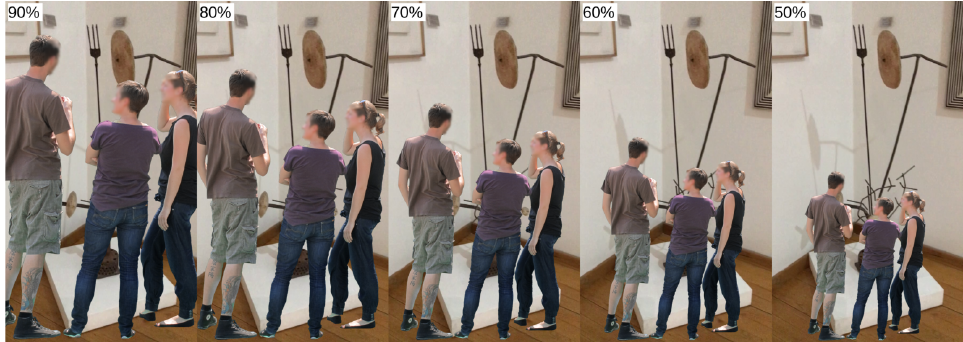
Figure 7. Example of figures of virtual visitors superimposed on images showing paintings, in order to simulate occlusions (the human silhouettes used originated from a freely available dataset